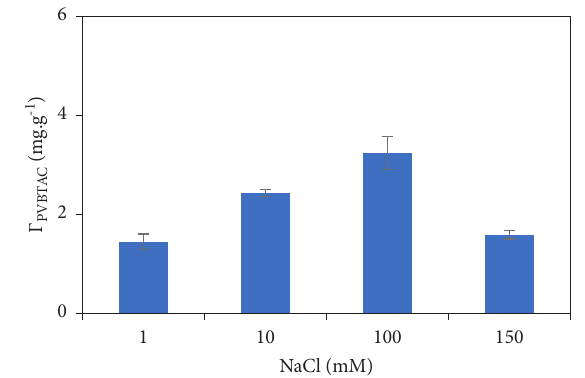
Figure 2: pH effect on the PVBTAC adsorption on the α -Al particles in different ionic strengths: ( ) 1mM, ( ) 10mM and ( ) 100mM NaCl with C i ,PVBTAC of 50ppm, t of 2h and m α -Al2O3 of 5 mg mL − 1 .